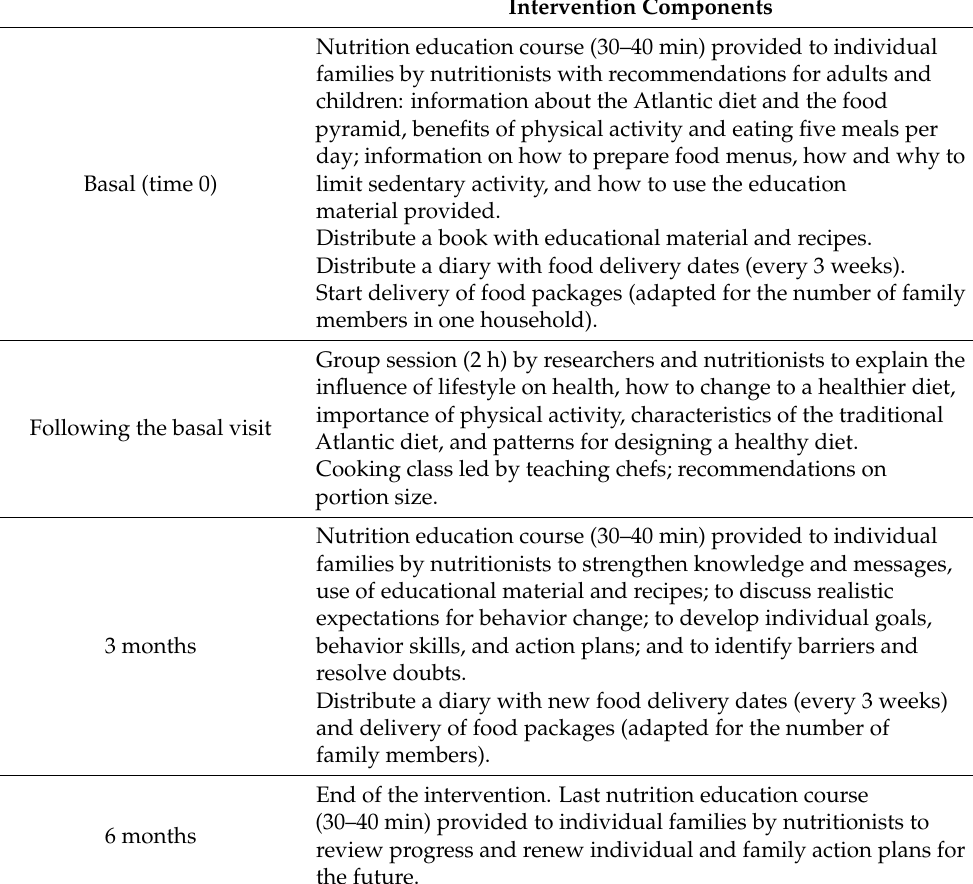
Table 1. Intervention